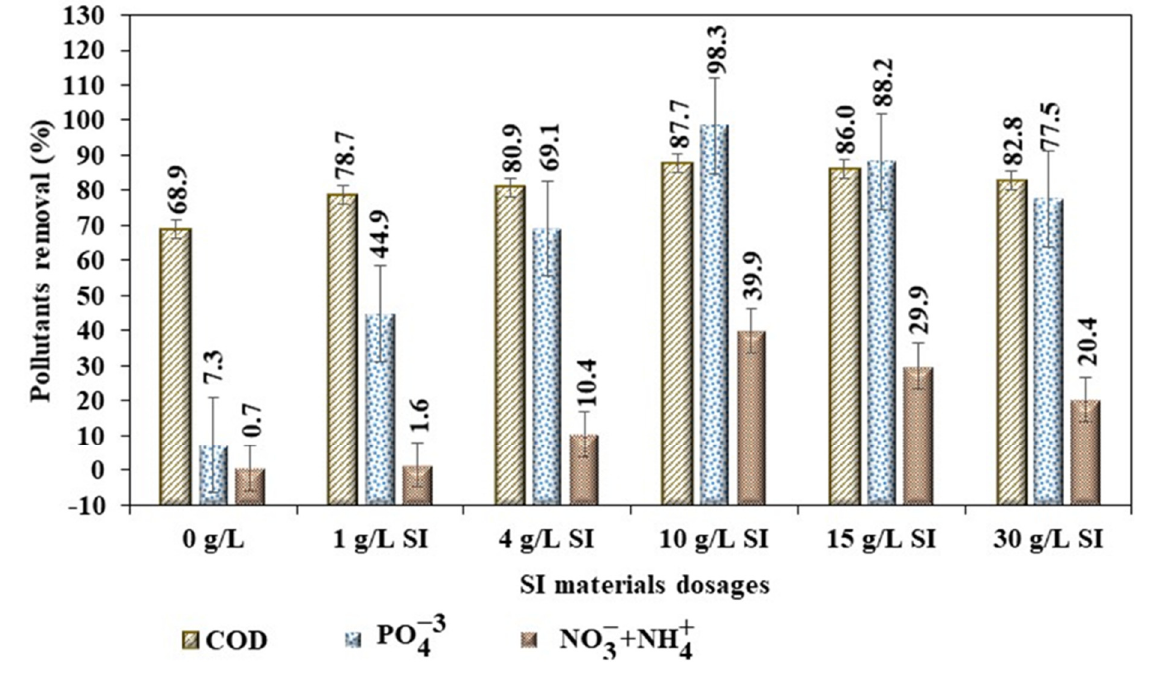
Figure 4. Comparison of maximum pollutants removal efficiencies among systems. SI materials’ dosages were 0 g, 4g/L, 10 g/L, 15 g/L and 30 g/L; Systems’ temperature, T = 37 ± 0.5 ◦